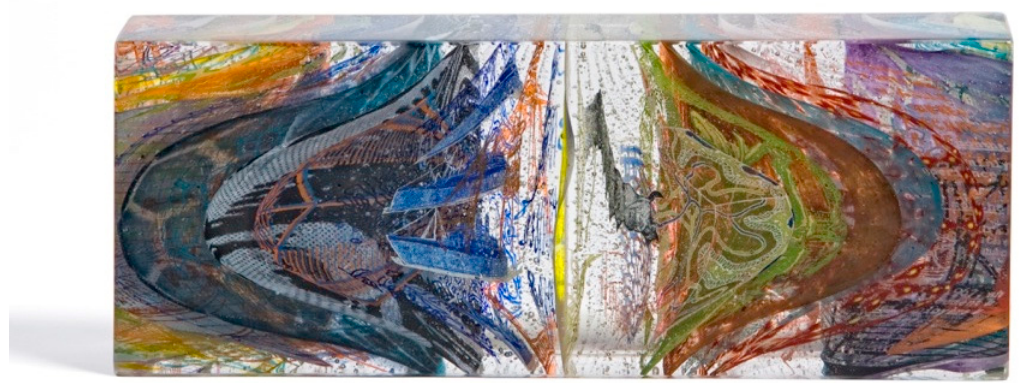
Figure 9. Jeffrey Sarmiento, Encyclopaedia ( Warp ), 2018. Screenprinted, fused and polished glass. Photo: David Williams.